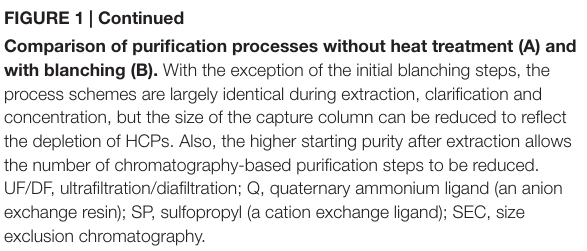
Frontiers in Plant Science |